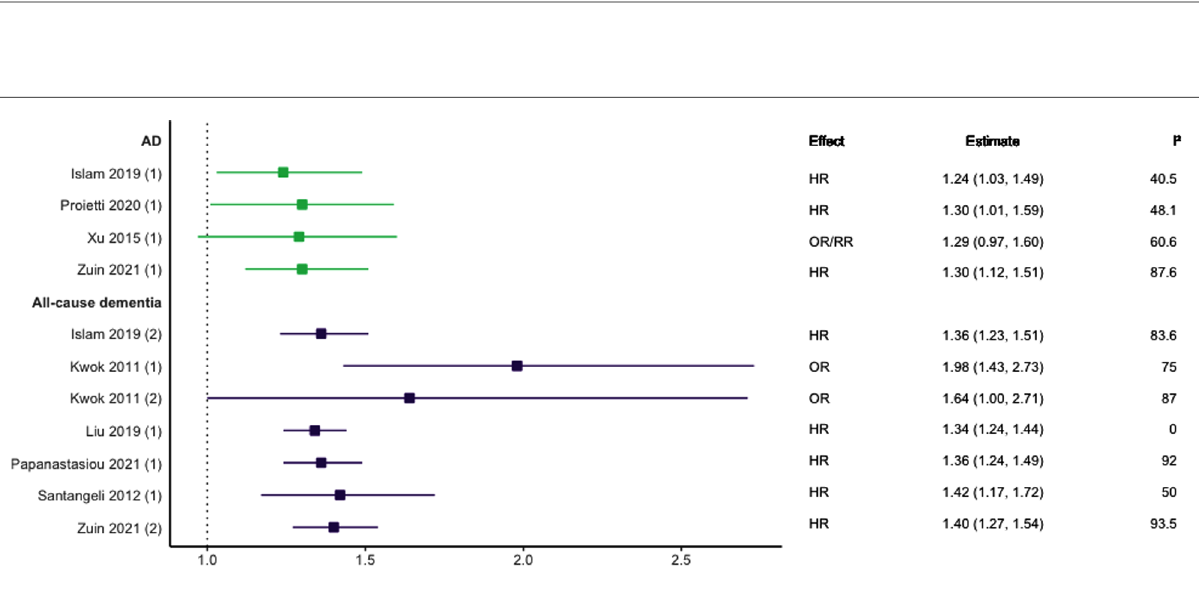
FIGURE 4 Effect estimates of meta-analyses reporting an association between atrial fi brillation and dementia, with the vertical line representing no effect. To note, Xu et al. treated ORs as approximates to RRs, as such, violations of this assumption may have implications for the comparability of ORs and RRs, meaning that interpretation of these pooled estimates should be done cautiously. AD, Alzheimer ’ s disease; HR, hazard ratio; OR, odds ratio; RR, risk